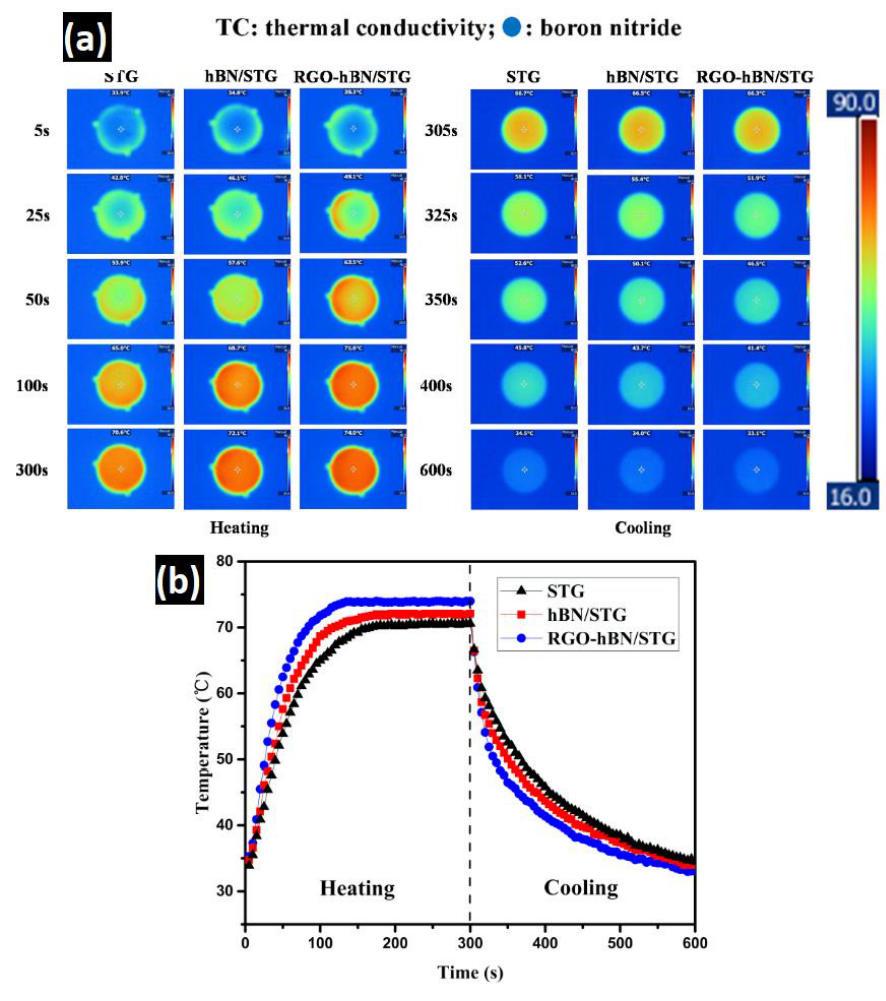
Figure 10. ( a ) Images recorded by a thermal imager with specimens heated on a homothermal platform and ( b ) the surface center temperature profiles of the samples as function of heating time (Reprinted with permission from MDPI, Copyrights 2019) [64].